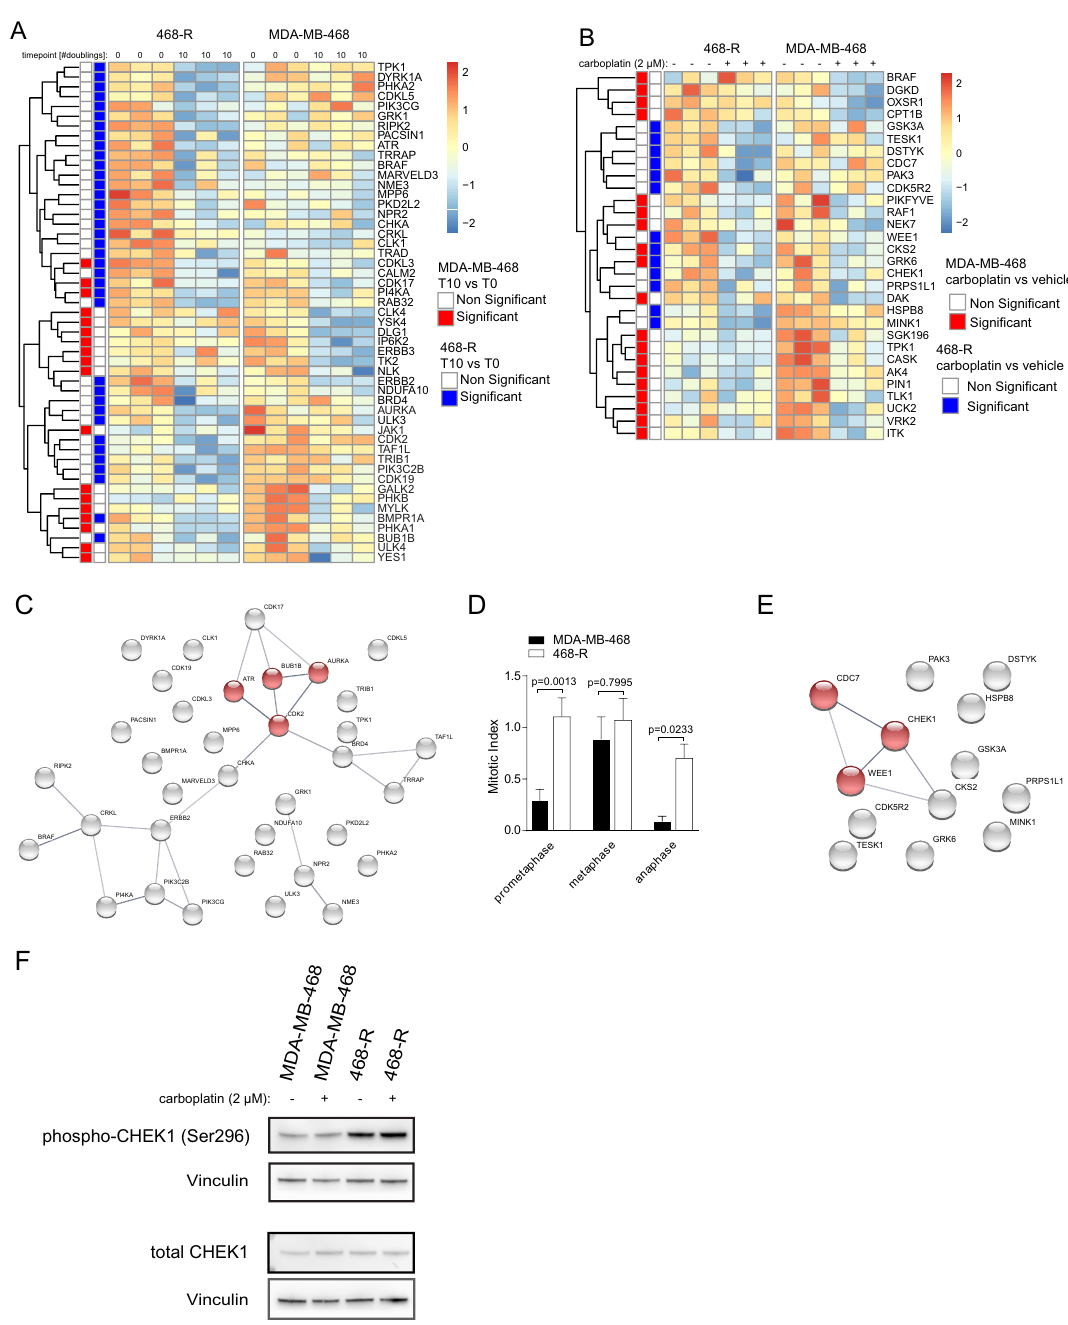
Figure 3. A pooled shRNA kinome screen to identify the vulnerabilities of carboplatin-resistant cells. A pooled shRNA kinome library was transduced into MDA-MB-468 and 468-R cells, and the cells were cultured in the absence or presence of carboplatin (0.3 µM for MDA-MB-468 cells or 2.0 µM for 468-R cells) for more than 10 doublings. ( A,B ) Heatmaps of gene-scores for genes whose targeting shRNAs were significantly depleted at the end of the shRNAi screen in the absence ( A ) or presence of carboplatin ( B ). Gene-scores were compared by ANOVA followed by Tukey’s HSD test. Significant genes (adjusted P value < 0.1) are indicated in red for MDA-MB-468 or in blue for 468-R cells. ( C ) The String pathway analysis of essential genes for 468-R cells. The regulators of the mitotic cycle are shown in red. ( D ) Mitotic index in DAPI-stained MDA-MB-468 (N = 2221) and 468-R (N = 4537) cells. Data are shown as Mean ± SEM. P values were determined by two-way ANOVA with Geisser–Greenhouse and Sidak’s corrections. ( E ) The String pathway analysis of carboplatin-survival genes for 468-R cells. The components of the G2/M Checkpoint are shown in red. ( F ) Immunoblot analysis of MDA-B-468 and 468-R cells treated for five days with vehicle or 2 μM carboplatin with the indicated antibodies. Uncropped blots are presented in Supplementary Figure